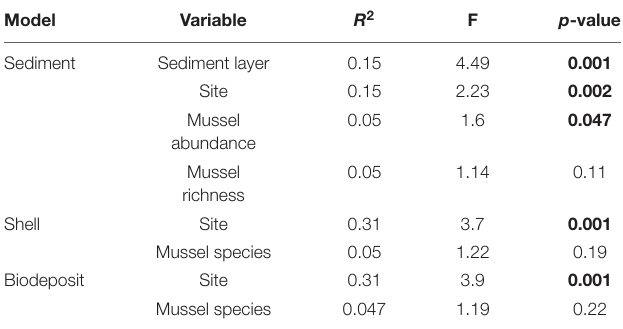
TABLE 3 | PERMANOVA outputs for sediment, shell, and biodeposit models.